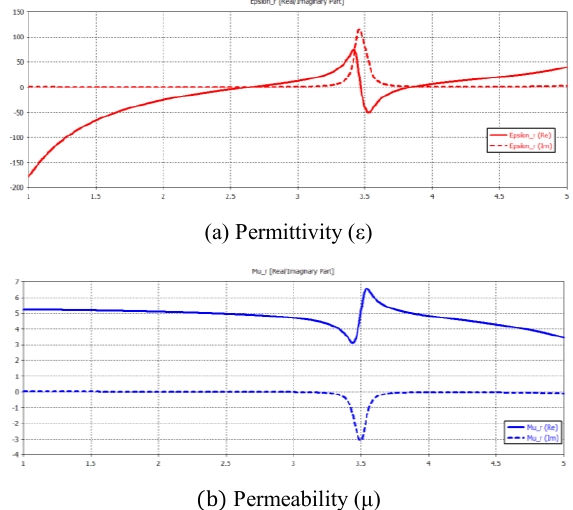
Fig. 2. (a) Effective permittivity’s real and imaginary parts. (b) Effective permeability’s real and imaginary parts.